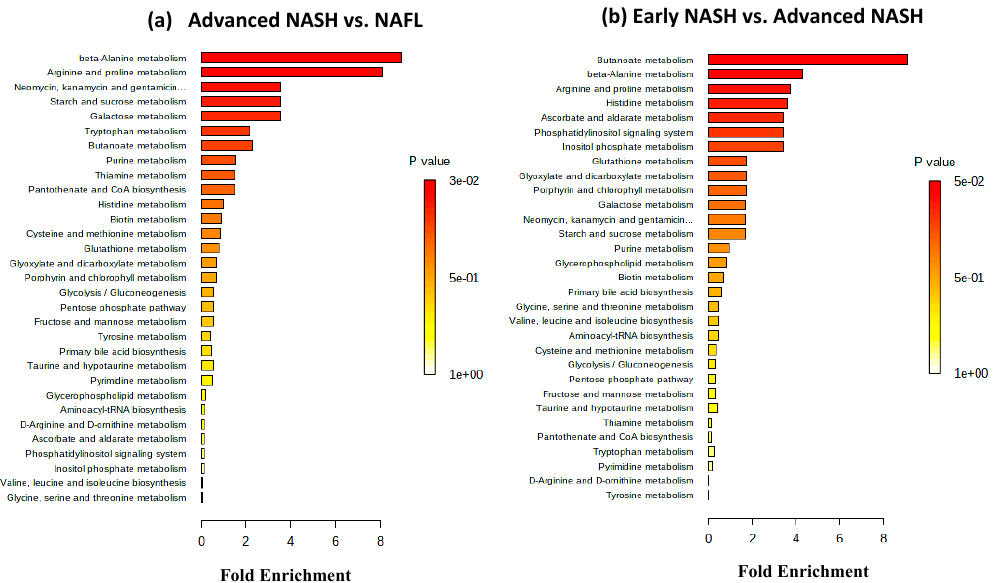
Figure 2. Biological patterns identified from metabolite set enrichment analysis. Metabolite data were derived from MS. The enrichment analysis combines functionally related metabolites to discern consistent changes among the related metabolites. The color and the bar length indicate p value and the fold enrichment, respectively. ( a ) In the advanced NASH vs. NAFL comparison, the analysis identified 31 sets, of which two sets that correspond to beta-alanine metabolism and arginine and proline metabolism exhibited high significance; the p value adjusted using false discovery rate for both sets was 0.02. ( b ) In the early NASH vs. advanced NASH comparison, 31 sets were also identified, of which one set that corresponds to butanoate metabolism exhibited high significance; its p value adjusted using false discovery rate was 0.05.